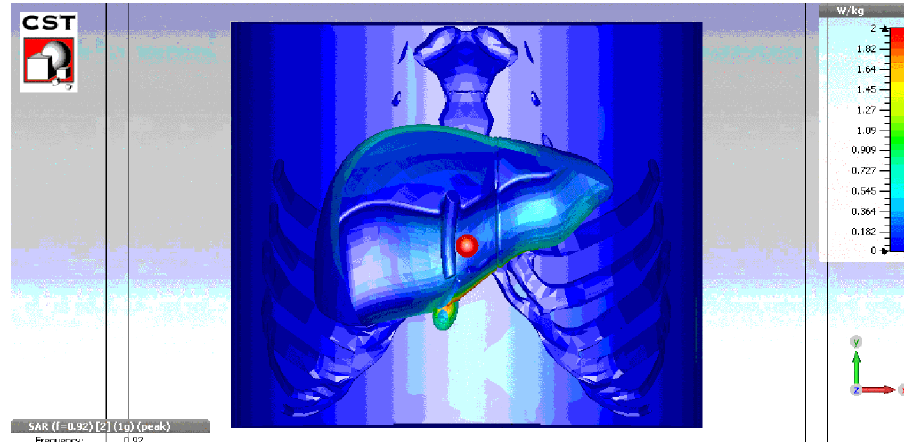
Figure 10: SAR by using PAS antenna after adding GNPs